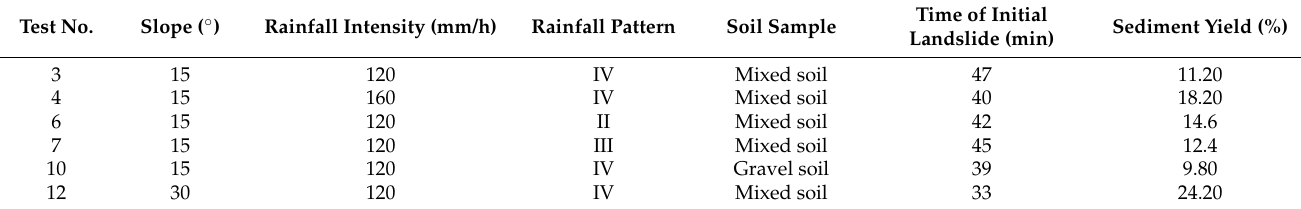
Table 3. Sediment yield from